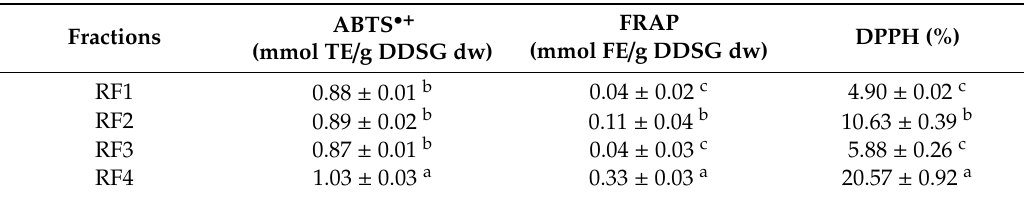
Table 4. Antioxidant activity of RF1-RF4 1 .